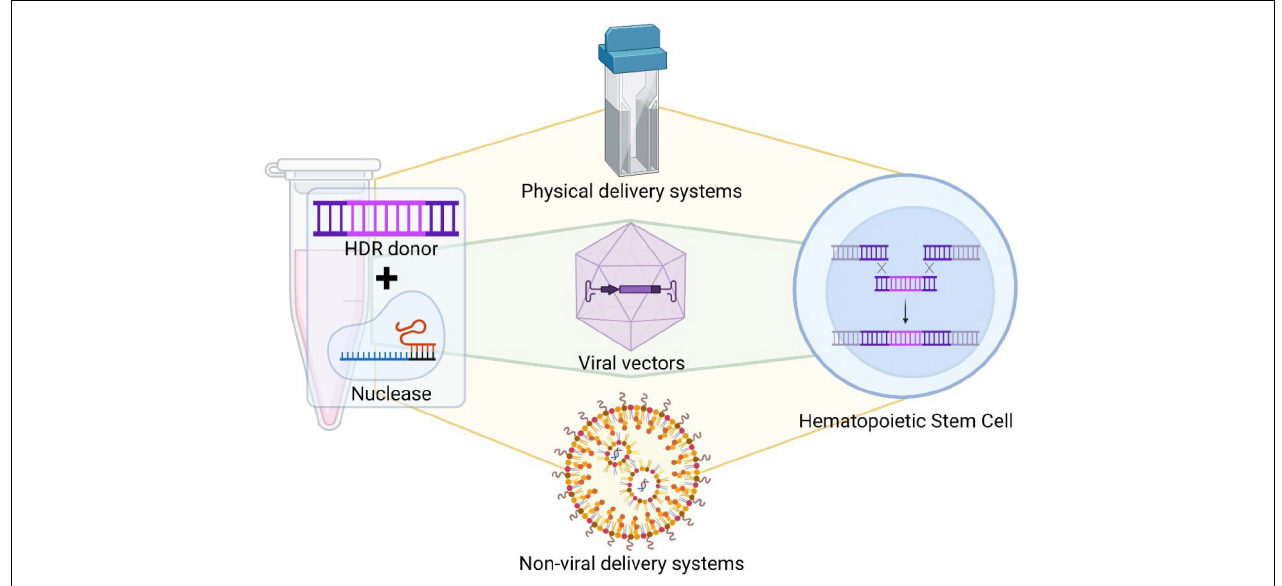
FIGURE 2 | Delivery systems of gene editing tools. Different gene editing tools can be delivered into hematopoietic cells by specific delivery systems, such as physical methods, viral vectors or non-viral delivery system. Each gene editing tool has to be modified to be adapted for a specific delivery method.